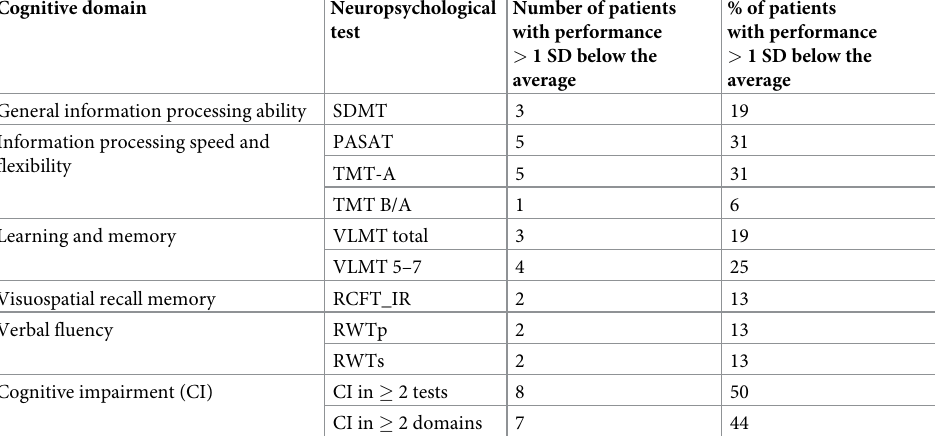
Table 3. Neuropsychological performance of chronic autoimmune demyelinating polyneuropathy (CADP) patients. SD = standard deviation; RCFT IR = Immediate Recall trial in the Rey Complex Figure Test; SDMT = Symbol Digit Modalities Test; VLMT total = total number of correctly recalled items in trials 1 to 5 of the Ver- baler Lern- und Merkfa¨higkeitstest; VLMT 5–7 = “trial 7”–“trial 5” difference in the VLMT; PASAT = Paced Auditory Serial Addition Test; TMT = Trail Making Test; RWT p/s = phonemic/semantic subtests of the Regensburger Wort- flu¨ssigkeits-Test. CI = cognitive